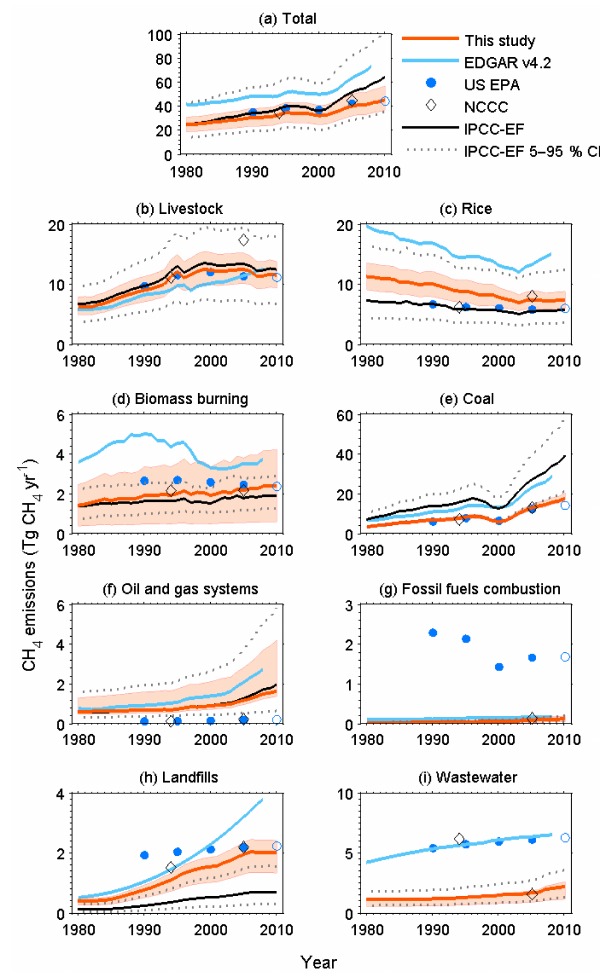
Figure 2. (a) Annual total anthropogenic CH 4 emissions in main- land China and (b–i) CH 4 emissions from different source sectors during the period 1980–2010. The shaded area shows the 95% con- fidence interval (CI) of our estimates. National Communication of Climate Change (NCCC) indicates the values from the initial and second NCCC of China reported to UNFCCC in 1994 and 2005. IPCC-EF refers to the estimates using the same method but IPCC default emission factors, and 5–95% CI is based on high and low estimates of emission factors. Note that the empty circle indicates projected 2010 value in EPA and the emission from fossil fuel com- bustion in 1994 is not reported in the initial NCCC of China reported to